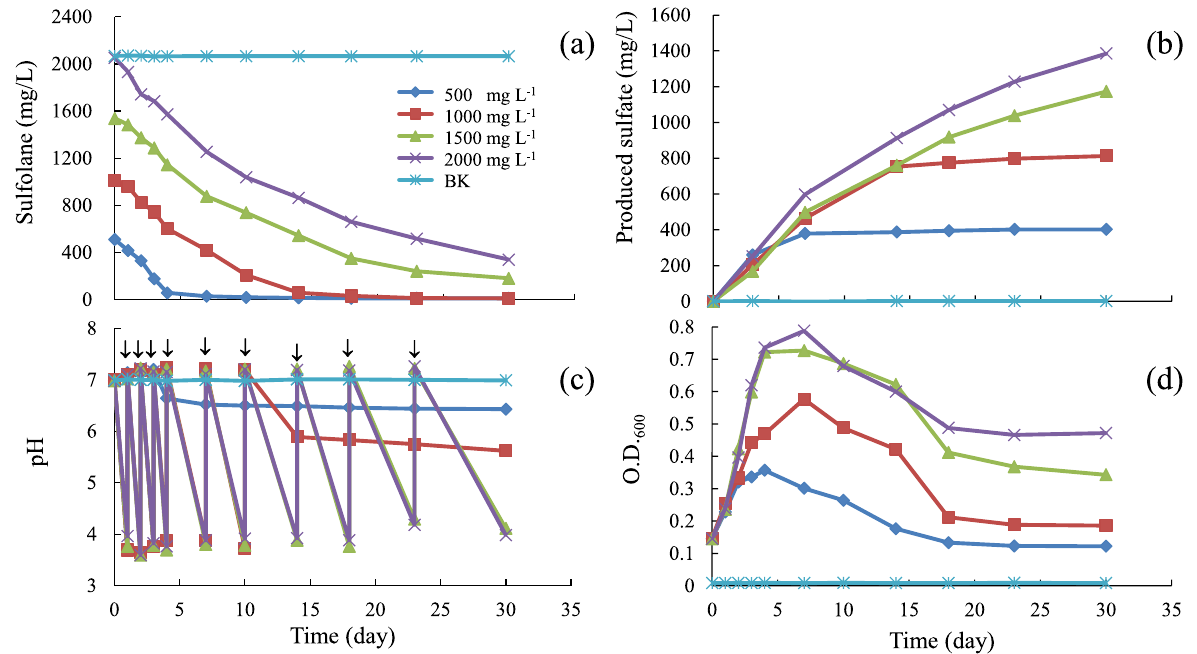
Fig. 3 Sulfolane ( a ), sulfate ( b ), pH ( c ) and O.D. 600 ( d ) variations during different sulfolane concentrations biodegradation by strain Cupriavidus sp. Y‑d at the pH of 7. Arrow indicates pH adjustment. BK refers to no added